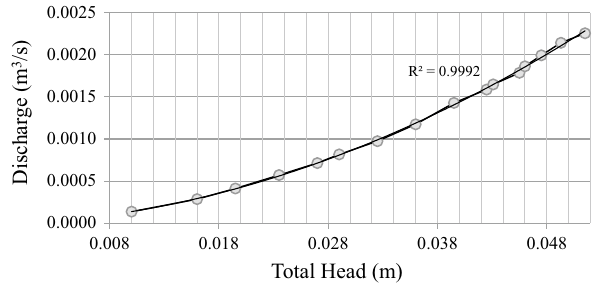
Fig. 6 Discharge–total head relation curve